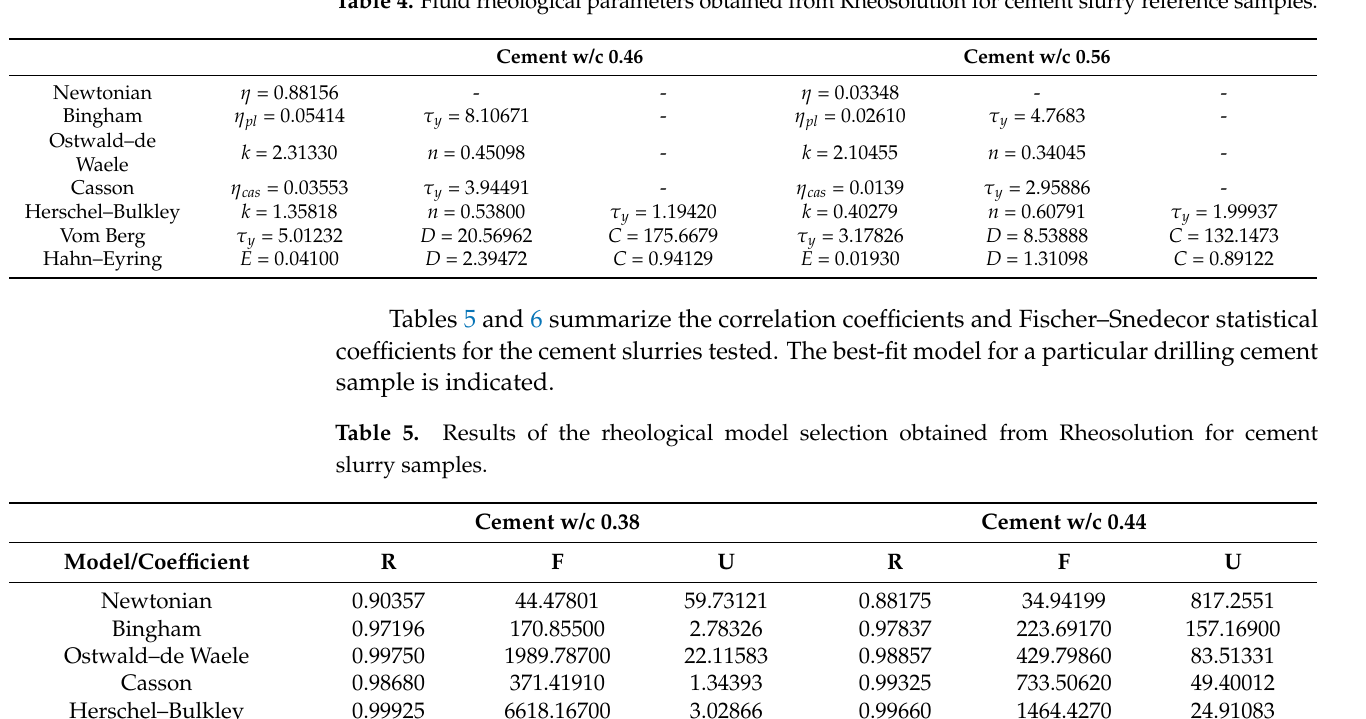
ment sample is indicated.